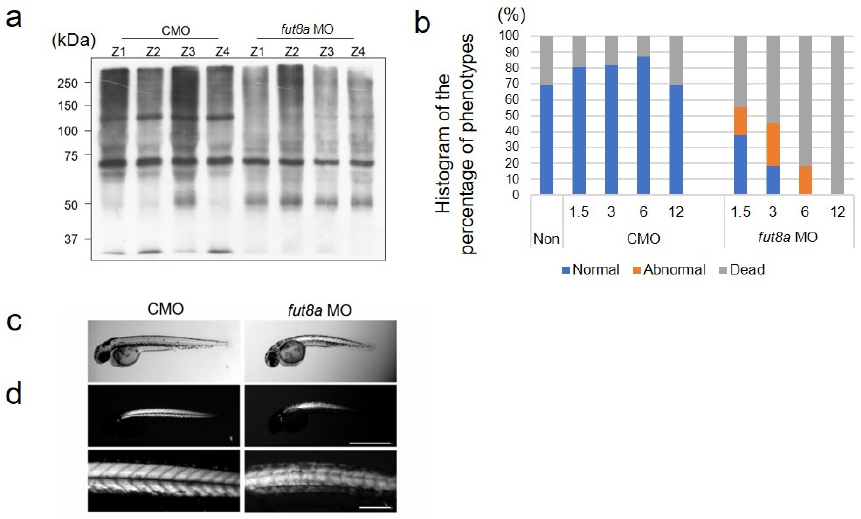
Figure 1. Zebrafish injected with fut8a MO showed abnormalities in skeletal muscle ( a ) Lectin blot, with AAL, of Zebrafish morphants injected with 3 ng of CMO or fut8a MO at 2 dpf. Total protein was visualized by Coomassie Blue staining and Ponceau staining (Supplemental Figure S1a,b): Histogram of the percentage of normal, abnormal, and dead fish in non-injected fish, CMO and fut8a MO injected fish at 2 dpf. Blue: normal, orange: abnormal, gray: dead. ( c,d ) Comparison of the CMO and fut8a MO injected zebrafish under bright field ( c ) and birefringence assay ( d ) at 2 dpf. d: Upper bar = 1 mm; lower bar = 200 μ m. Non: non-injected zebrafish.